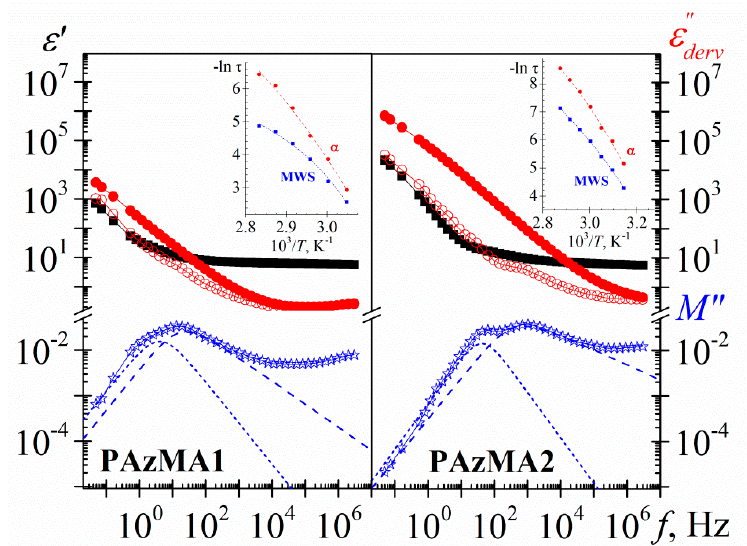
Figure 13. Frequency dependence of the dielectric constant (square), experimental loss permittivity (full circle), derivative loss permittivity (open circle) and derivative loss modulus (star) spectra of the PAzMA samples at 60 °C. Short dashed lines correspond to the MWS process and dashed lines to the α relaxation process. Inset: Temperature dependence of the relaxation time in the Arrhenius coordinates.